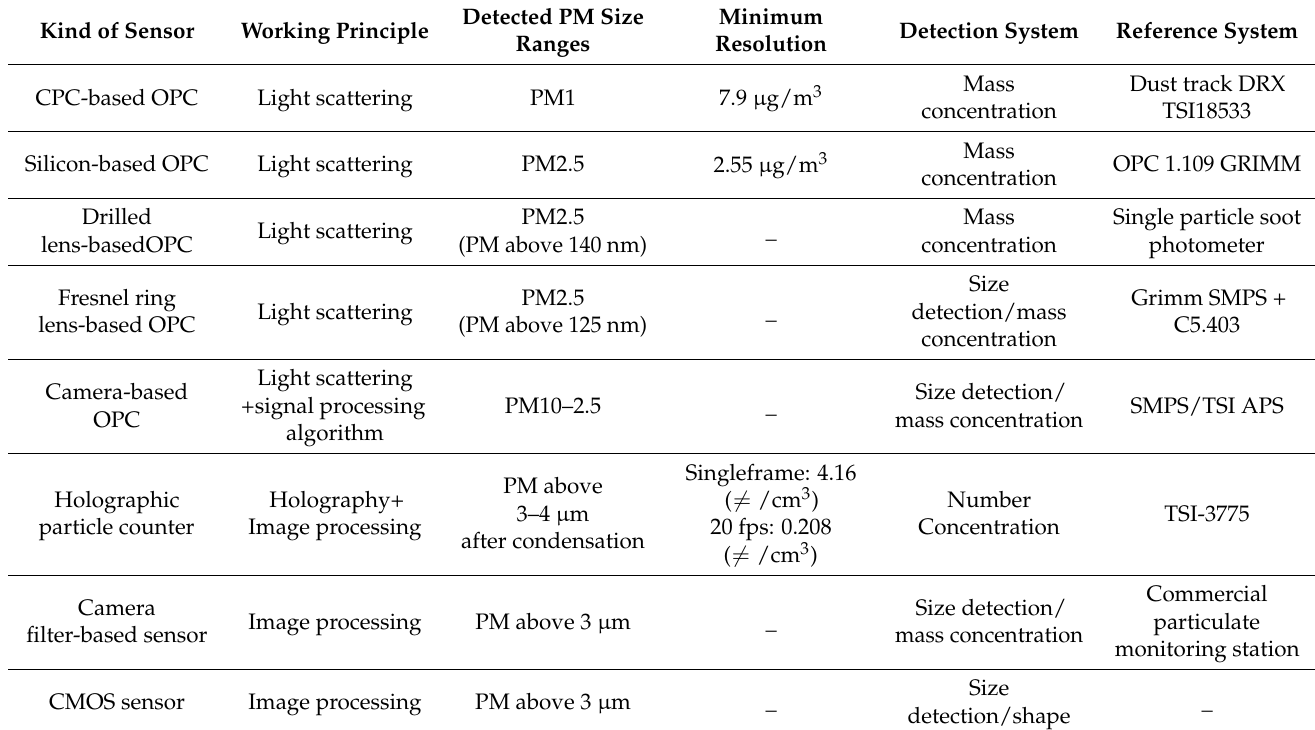
Table 5. Summary of the main newly developed mobile optical sensors reporting information on instrumentation, measured parameters, and resolution.